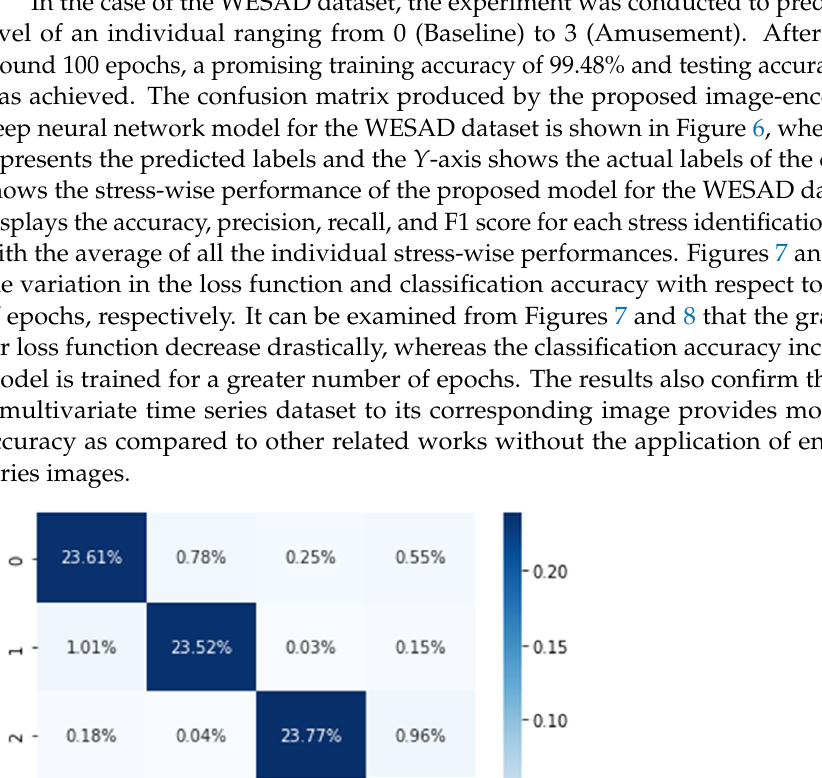
Table 2. Performance of our proposed image ‐ encoding ‐ based deep neural network model for class ‐ wise accuracy of WESAD dataset with different stress levels.